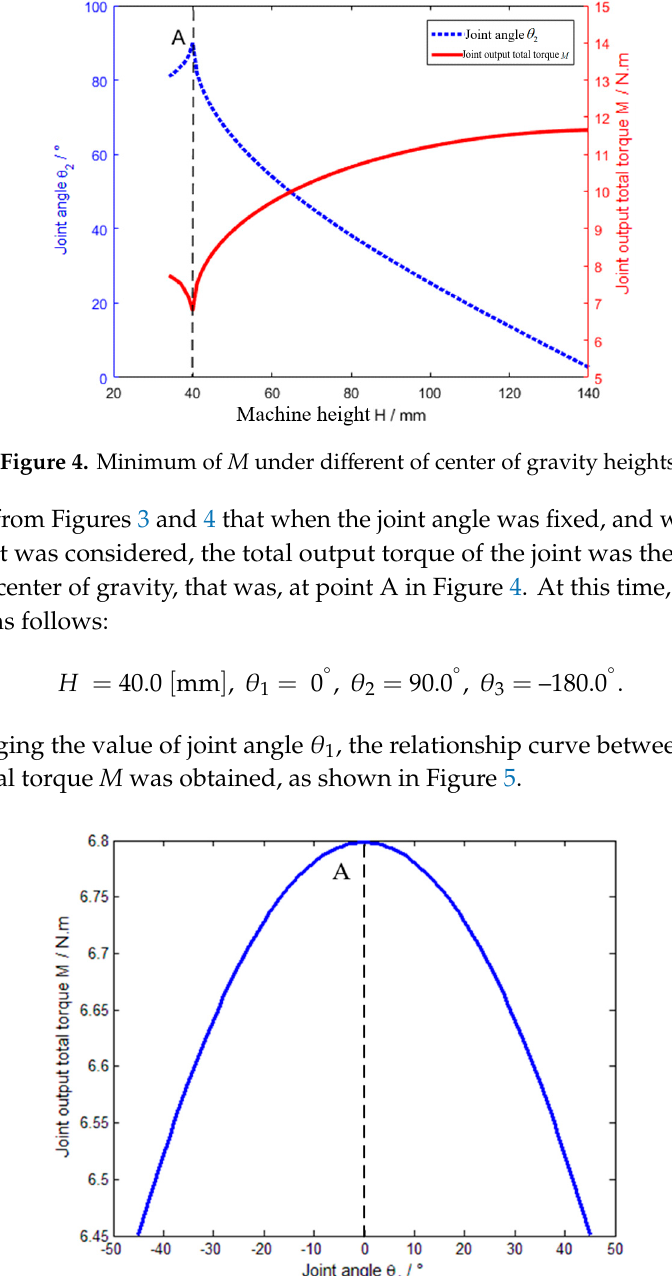
Figure 5. Relationship between joint angle θ 1 and M under different values of θ 1 .